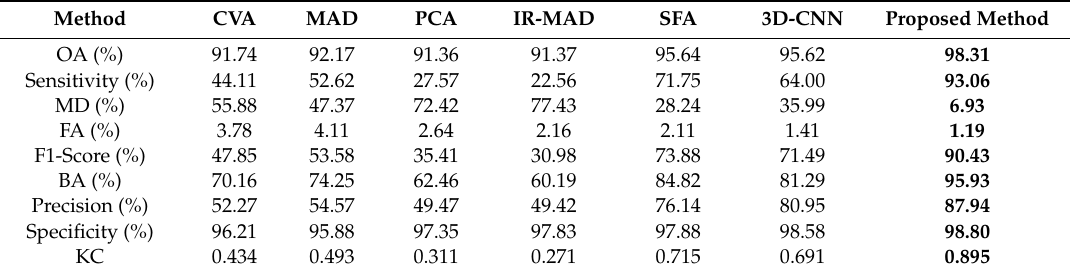
Table 12. The accuracy of different change detection methods for the PolSAR-San Francisco1 dataset (the best performance for each method appears in bold).